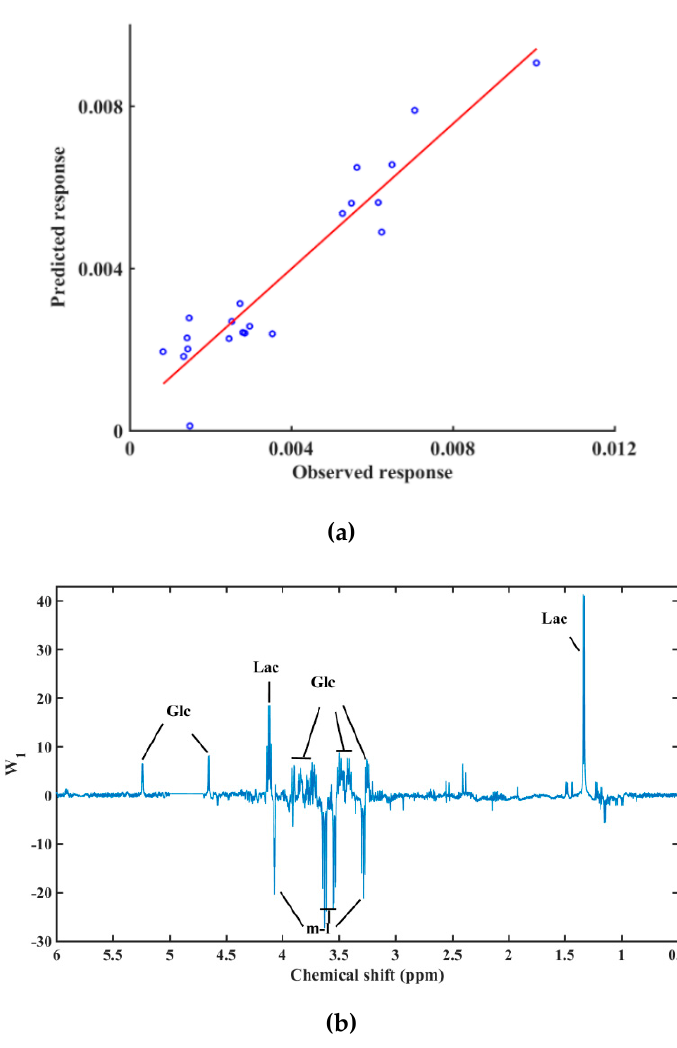
Figure 4. Results from the partial least squares (PLS) regression model between the plasma NMR spectra (X-variables) and cerebral microglia density (y-variable) obtained by three components, validated by the leave-one-out method (R 2 = 0.89, Q 2 = 0.55, and root mean square prediction error (RMSPE) = 1.6 × 10 − 3 ). ( a ) Predicted versus measured cerebral microglia density, ( b ) PLS weights revealing NMR variables that are important predictors. Abbreviations: Glc: glucose; Lac: lactate; m-I: myo -Inositol.